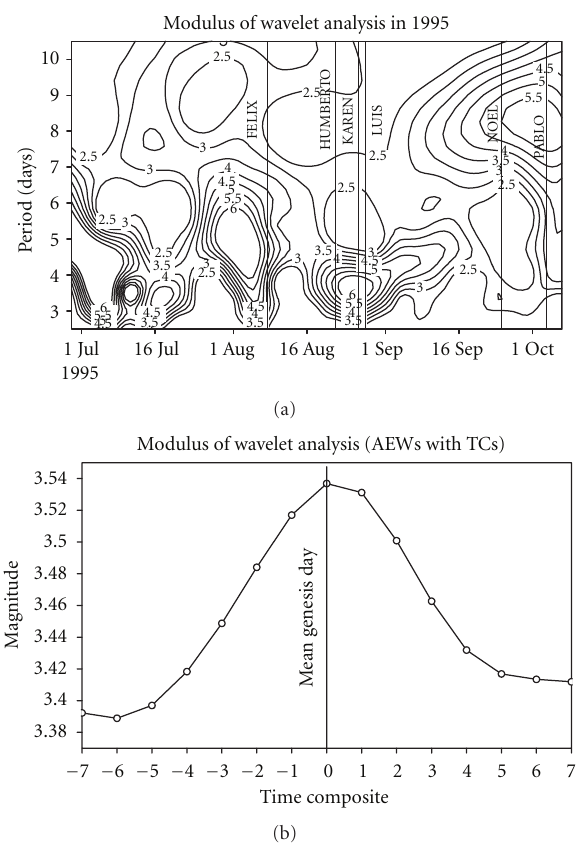
Figure 2: Modulus of the wavelet analysis on the meridional wind at 700 hPa (a) in 1995 over the domain (27.5 ◦ W–15 ◦ W, 5 ◦ N– 17.5 ◦ N). The line represents the mean genesis days of cyclones obtained from the Best Track of NHC. Modulus of the wavelet analysis in the 3–5-day band periods ( t = 0 corresponds to the mean genesis day from NHC archives) performed over the domain (27.5 ◦ W–15 ◦ W, 5 ◦ N–17.5 ◦ N) for AEWs associated with cyclones